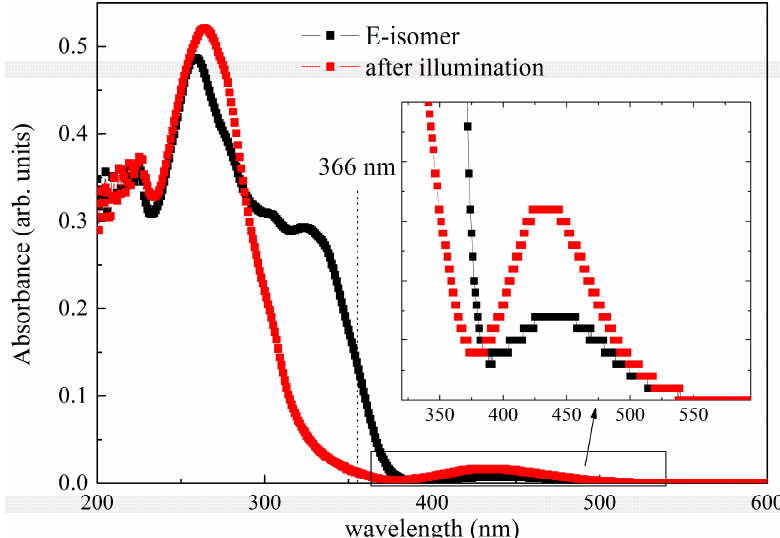
Figure 9. UV-Vis absorption spectra of 8BVJH12 solution 10 mg/L in dichloromethane before and after illumination with UV light and marked illumination wavelength 366 nm (dashed line).